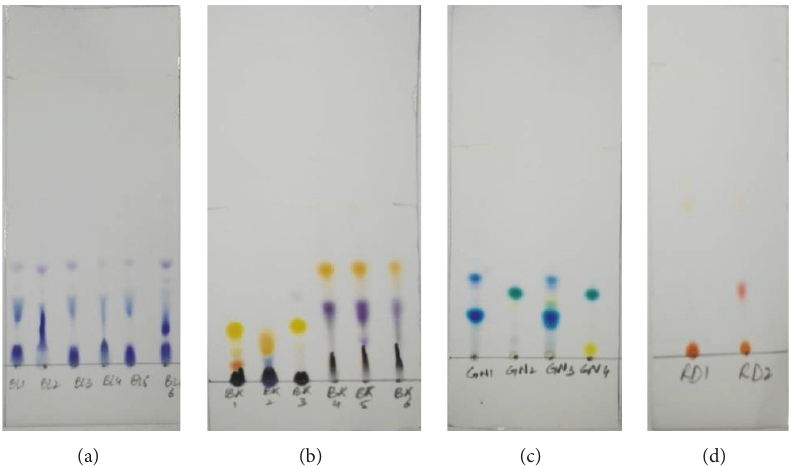
Figure 5: TLC plate developed for (a) blue fountain pen inks, (b) black fountain pen inks, (c) green fountain pen inks, and (d) red fountain pen